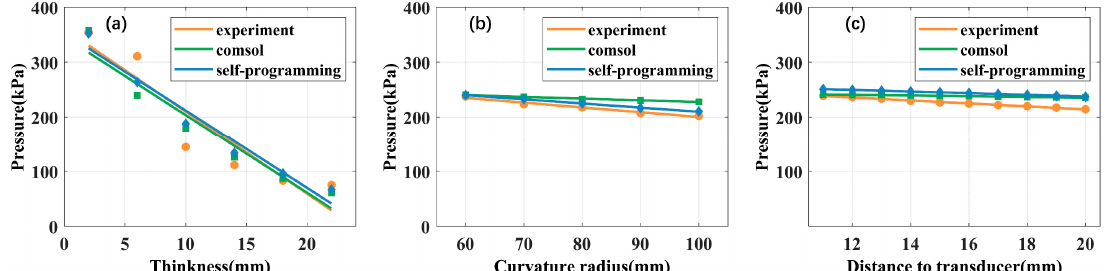
Figure 6. Trend chart of acoustic pressure changes under different conditions. ( a ) The trend of acoustic pressure changes due to changes in skull model thickness; ( b ) the changing trend of acoustic pressure due to changes in the radius of curvature of the skull model; ( c ) the changing trend of acoustic pressure due to the change of the distance between the skull model and the transducer.